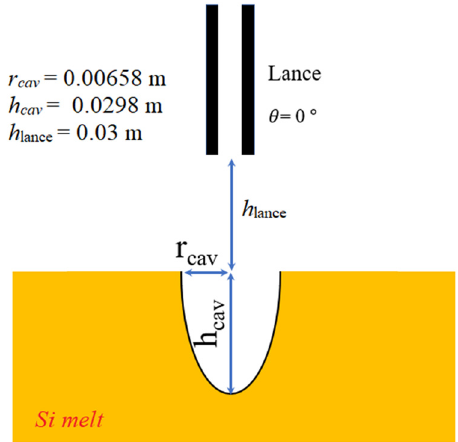
Figure 9: The calculated geometry of the impinged point on melt surface in vacuum condition, the dimensions are presented in a right